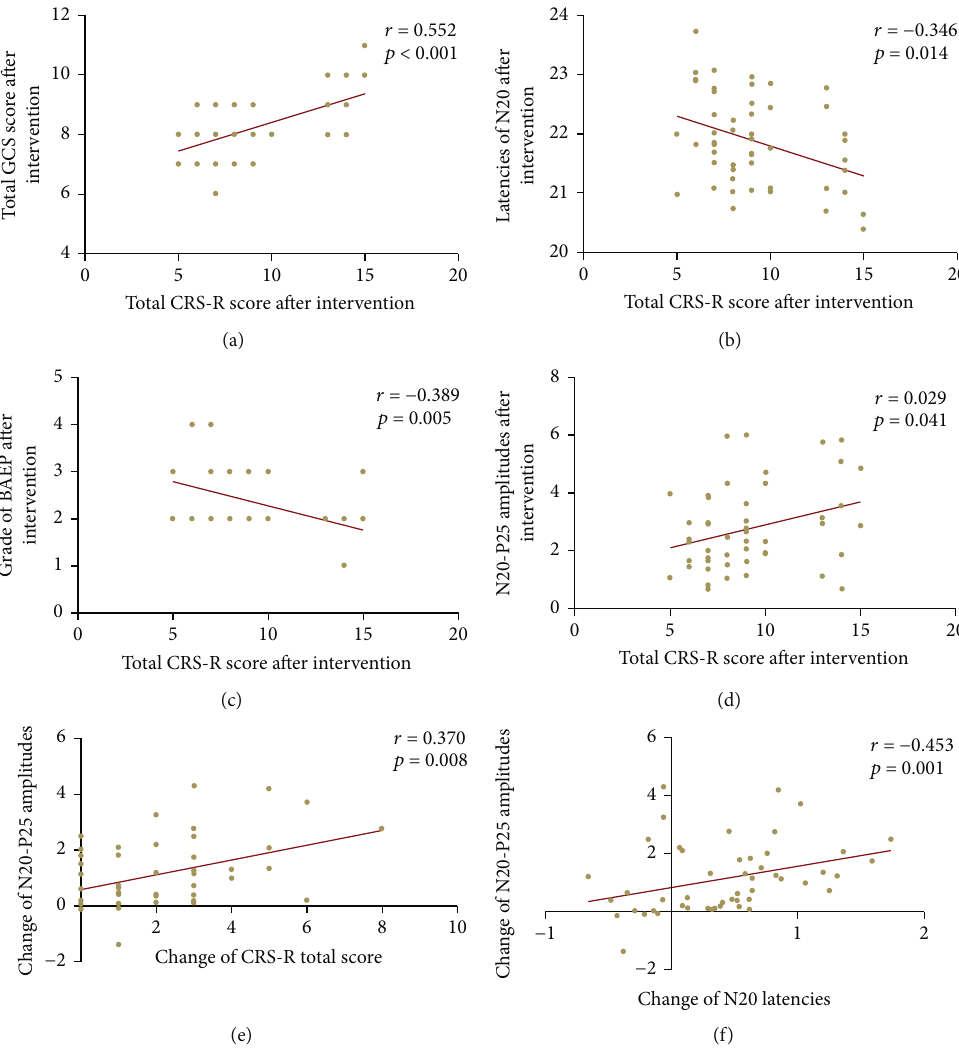
Figure 5: Correlation between the scores of clinical scales and the parameters of electrophysiological assessments after intervention. (a) The total GCS score was signi fi cantly related to the total CRS-R score. (b) The N20 latency exhibited a signi fi cant negative correlation with the total CRS-R score. (c) The BAEP grade was related to the total CRS-R score. (d) The total CRS-R score was related to the N20-P25 amplitude. The change of N20-P25 amplitude was related to (e) the change of total CRS-R score and (f) N20